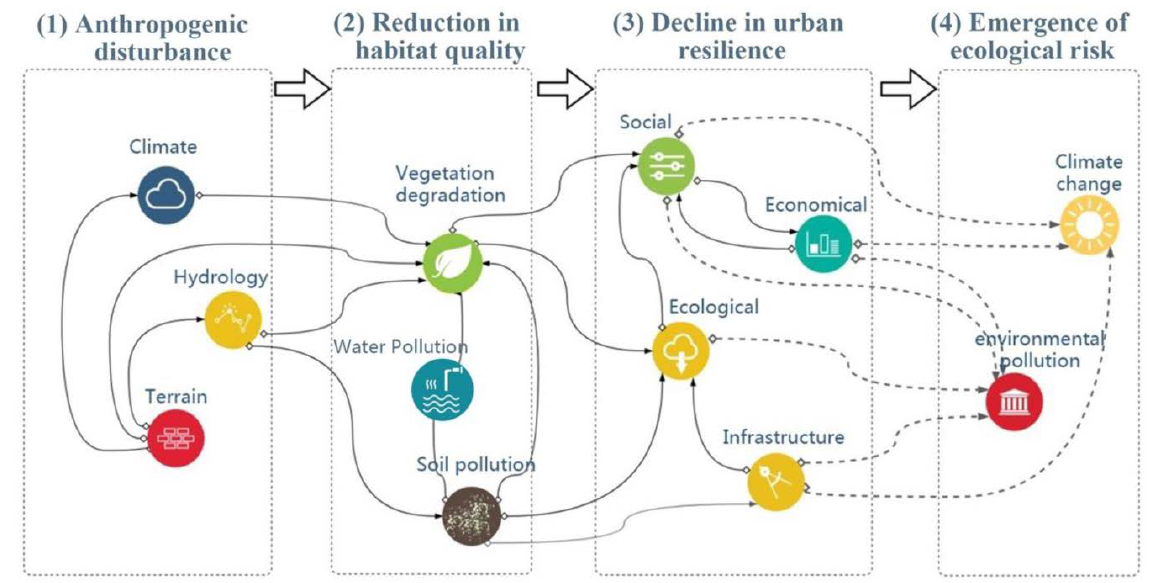
Figure 1. Anthropogenic disturbance (1) induced decline in habitat quality (2) leading to a reduction in ecosystem resilience (3) and an increase in ecological risks